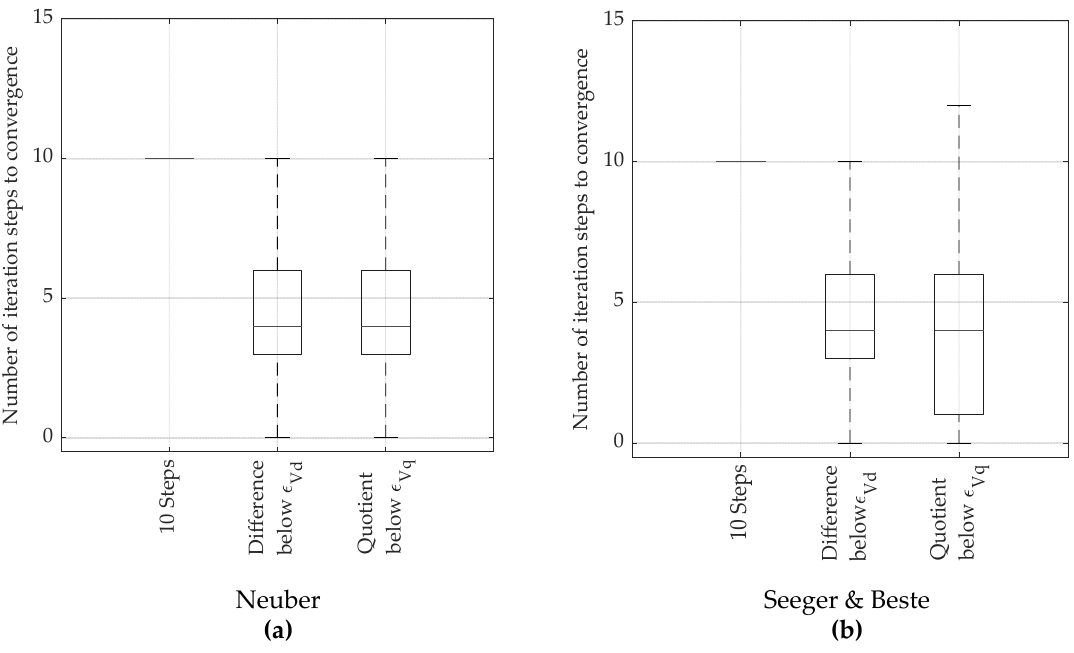
Figure 5. Number of Newton iterations required to reach the termination criteria when performing the extended Neuber notch root approximation ( a ) and the notch root approximation according to Seeger and Beste ( b ).